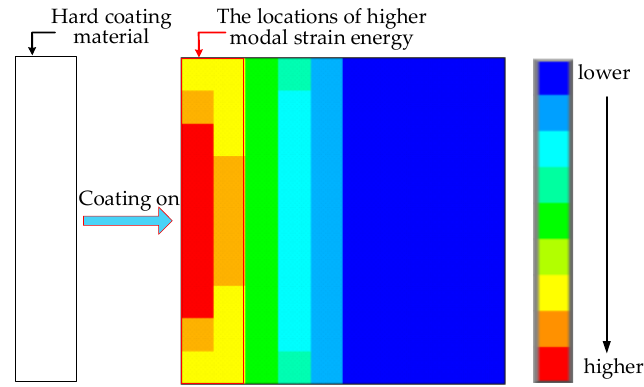
Figure 3. A simple optimization schematic diagram for hard ‐ coating thin plate structure.